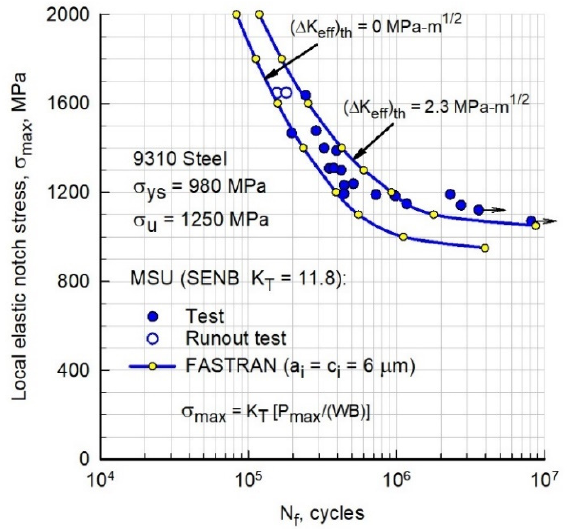
Figure 11. Measured and predicted stress-life behavior under Cold-Turbistan+ spectrum loading.